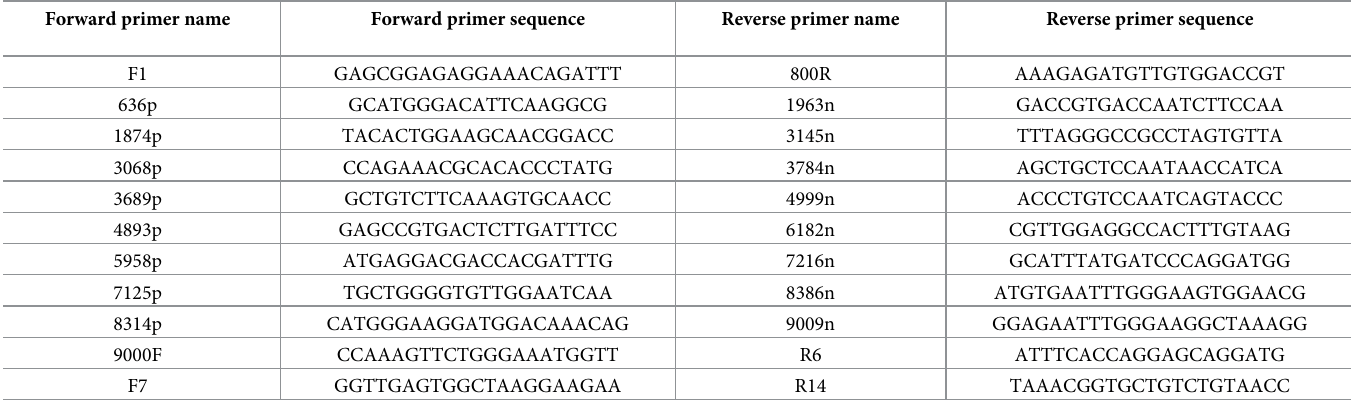
Table 2. Primers used to amplify and sequence St. Louis encephalitis